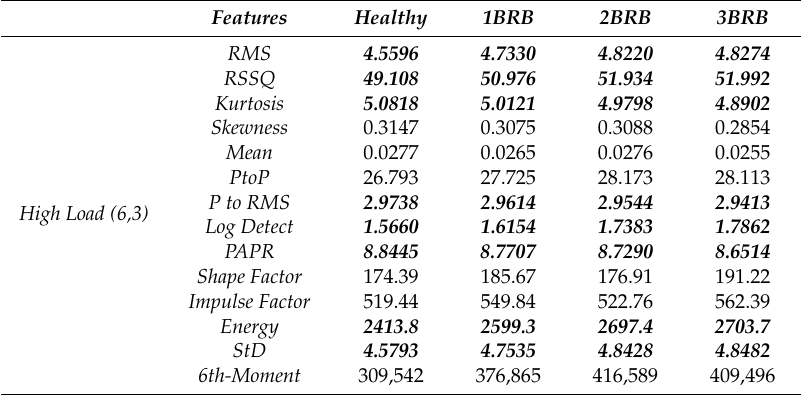
Table 3. Mean Value of Statistical Features for Healthy and Faulty Motor in High Load.